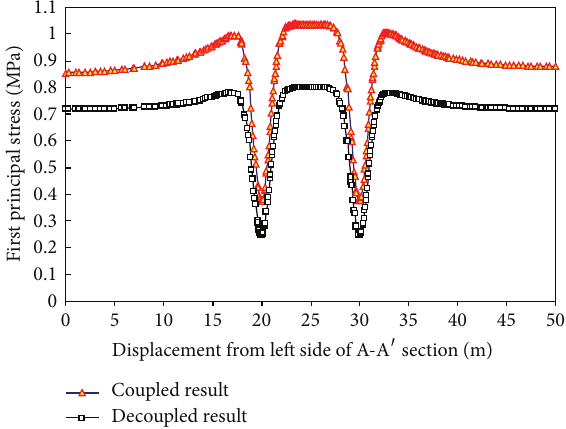
Figure 18: Contrast of first principal stress between coupled and decoupled